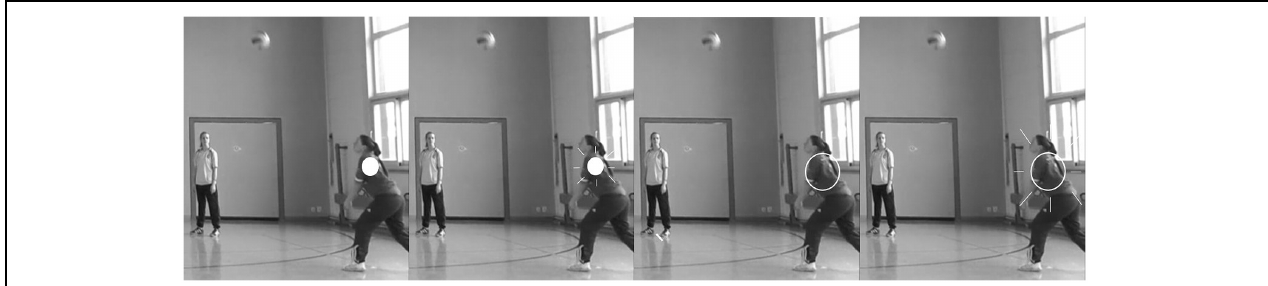
FIGURE 1 | Visual-cue markers (small/static, small/flashing, large/static, and large/flashing) in a selected frame of the video footage. Only the two players on the right side of the screen are shown, the player in the front is receiving the ball; original tapes were colored with red markers.